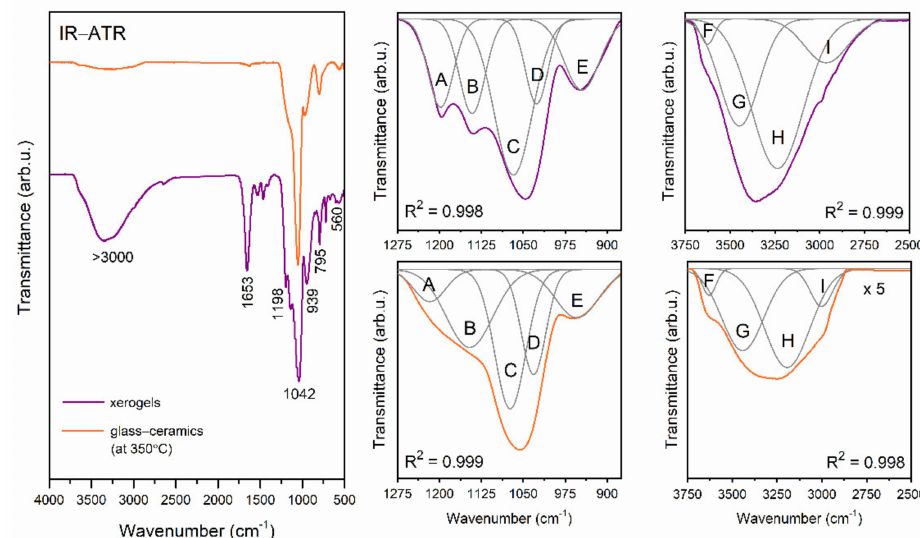
Figure 2. IR-ATR spectra recorded for xerogels and glass-ceramics. The deconvolution of bands characteristic for silicate host (1275–875 cm − 1 ) as well as OH moieties and C–H bonds (3750–2500 cm − 1 ) was also